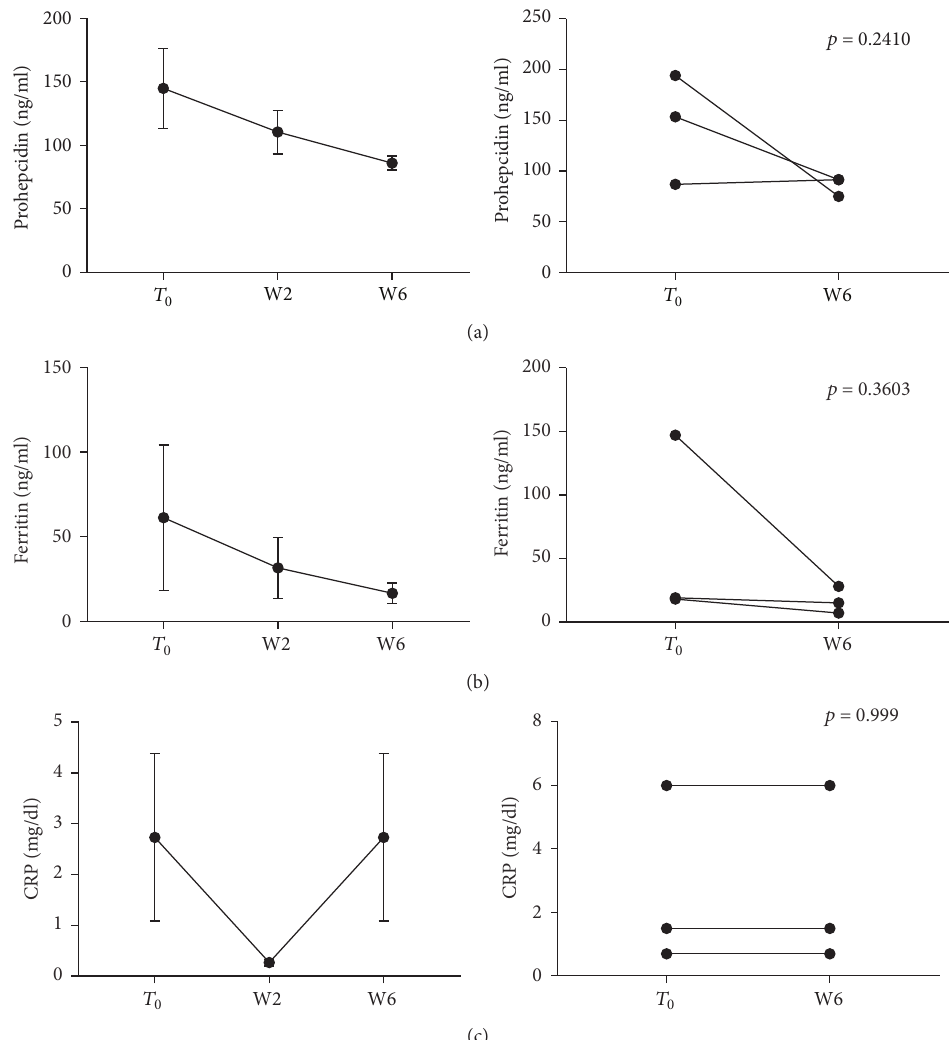
Figure 4: Prohepcidin and acute phase protein levels during anti-TNF therapy in UC patients. Blood samples were collected before each anti- TNF administration and parameters measured. Statistical analysis was performed using Student’s 𝑡 -test for paired data. Data are presented as single data point or as mean ±